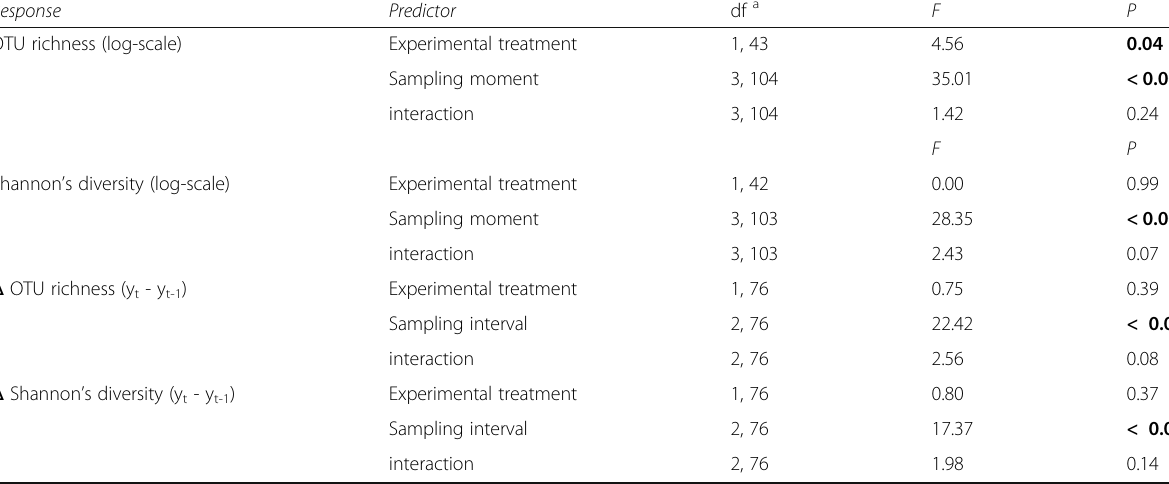
Table 3 Statistical analysis of host-associated microbiota alpha diversity Response